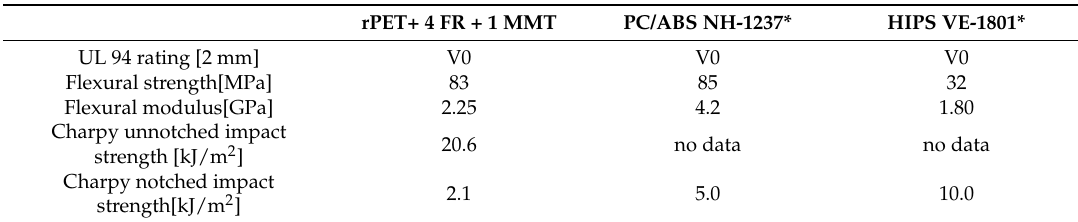
Table 6. Comparison of raw materials used for TV parts.